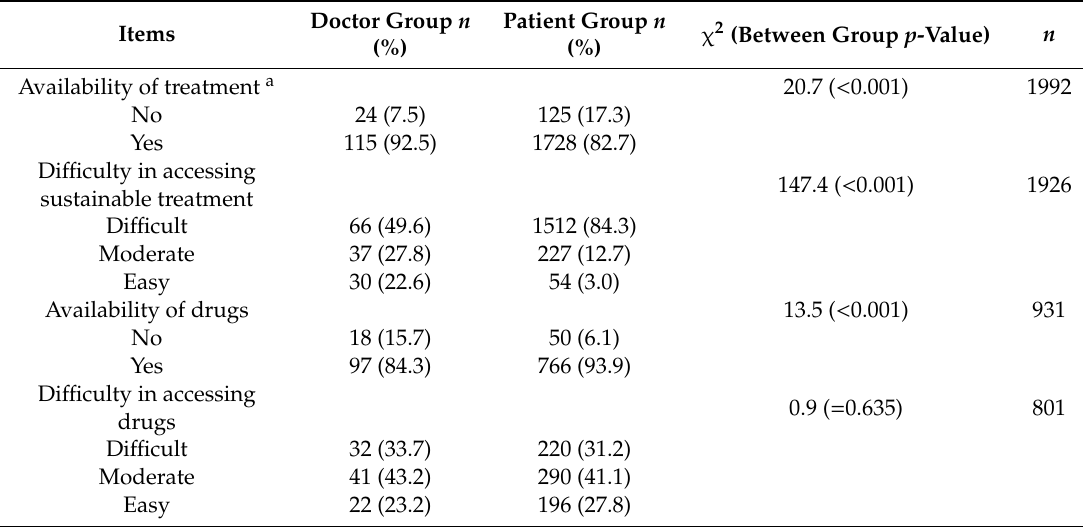
Table 3. Perceptions on the availability and accessibility to treatment and drugs for rare diseases between the two